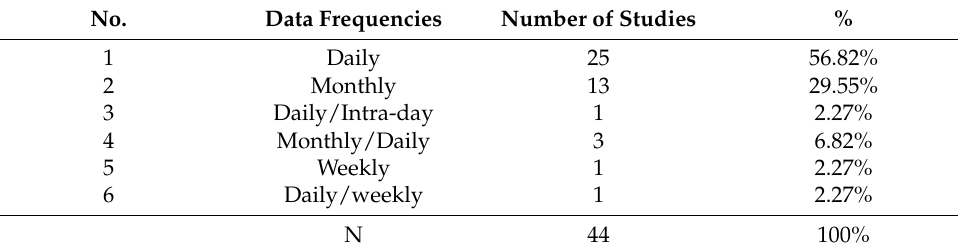
Table 3. Frequency of data utilized in